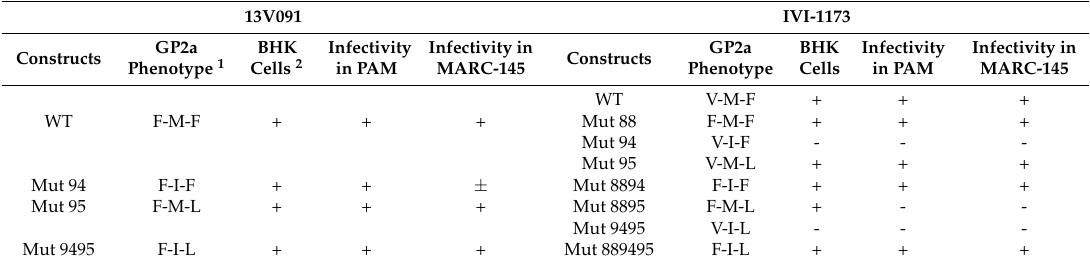
Table 2. Viral protein expression and infectivity of the mutant